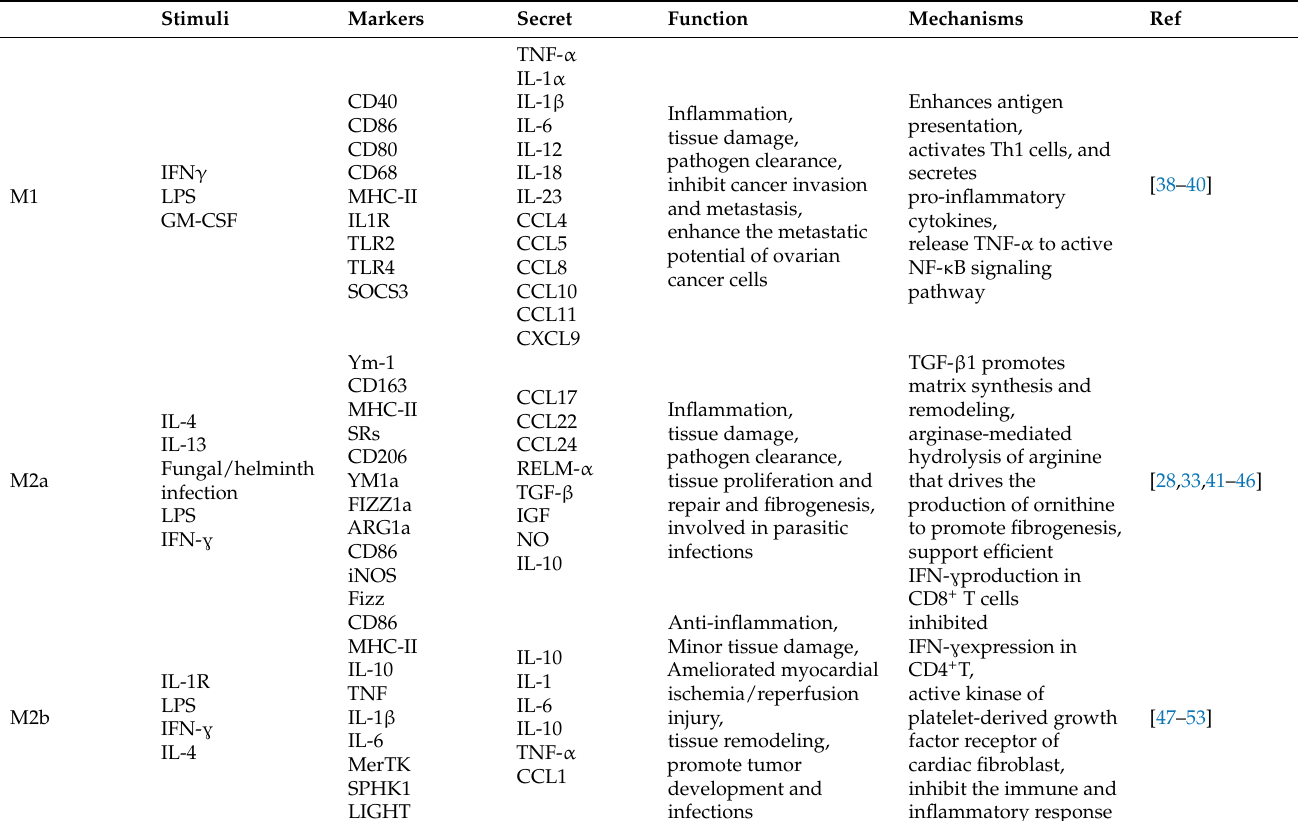
Table 1. Characteristics of M1 and M2 (M2a, M2b, M2c, and M2d) subtype